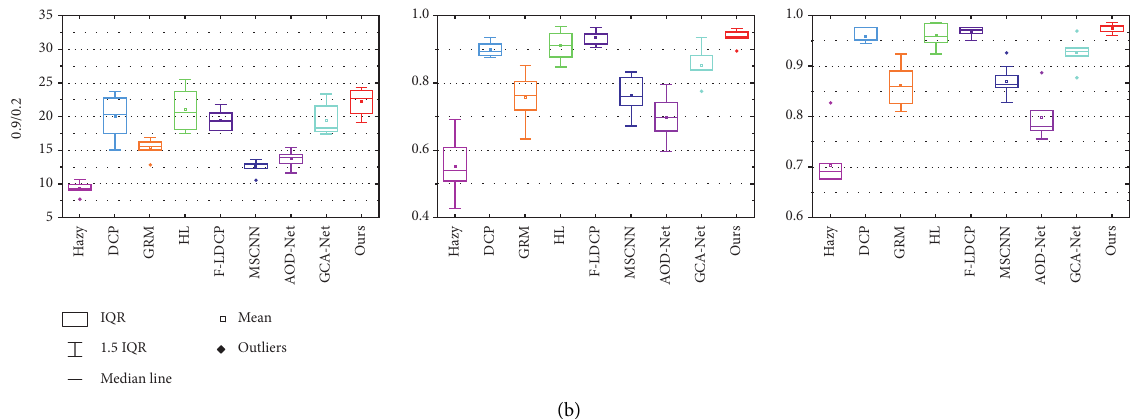
� 0 . 8/ t � 0 . 6, A � 0 . 9/ t � 0 . 6, A � 0 . 8/ t � 0 . 4, A � 0 . 9/ t � 0 . 4, A � 0 . 8/ t � 0 . 2, and A � ∞ ∞ ∞ ∞ ∞ ∞